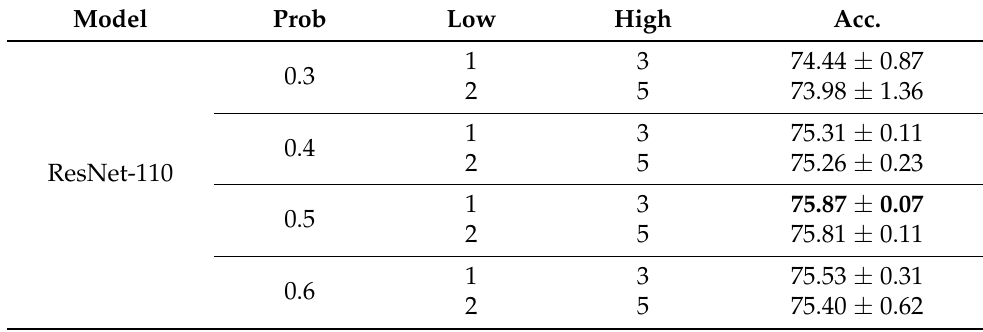
Table 9. Impact on parameters of probability with fixed low and high when taking RALR